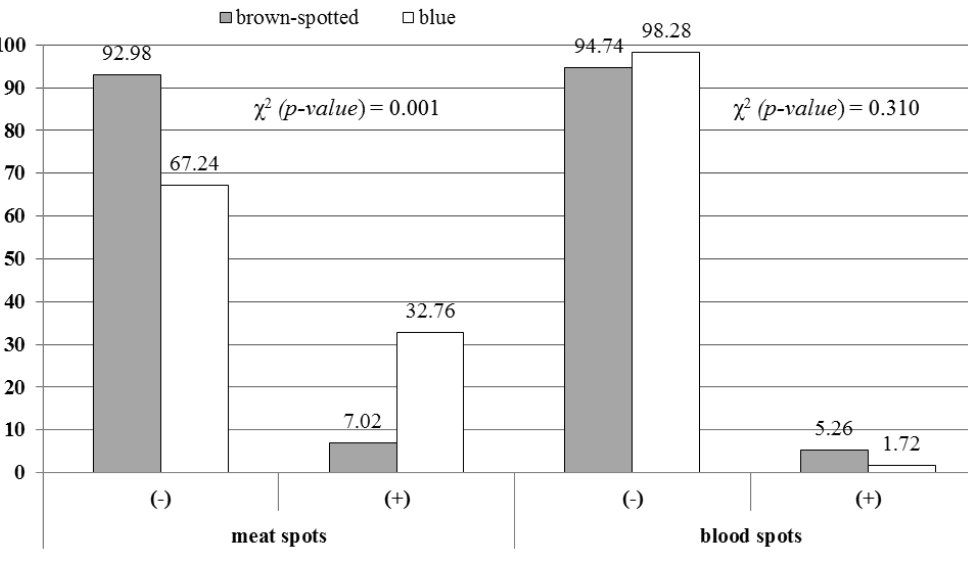
Figure1. ProportionsofJapanesequaileggswithmeatandbloodspotsdependingontheeggshellcolour. On the basis of the data obtained, the relationships between the quality characteristics of table eggs from Japanese quail were determined (Table 2). A significant negative correlation between Figure 1. Proportions of Japanese quail eggs with meat and blood spots depending on the eggshell colour.